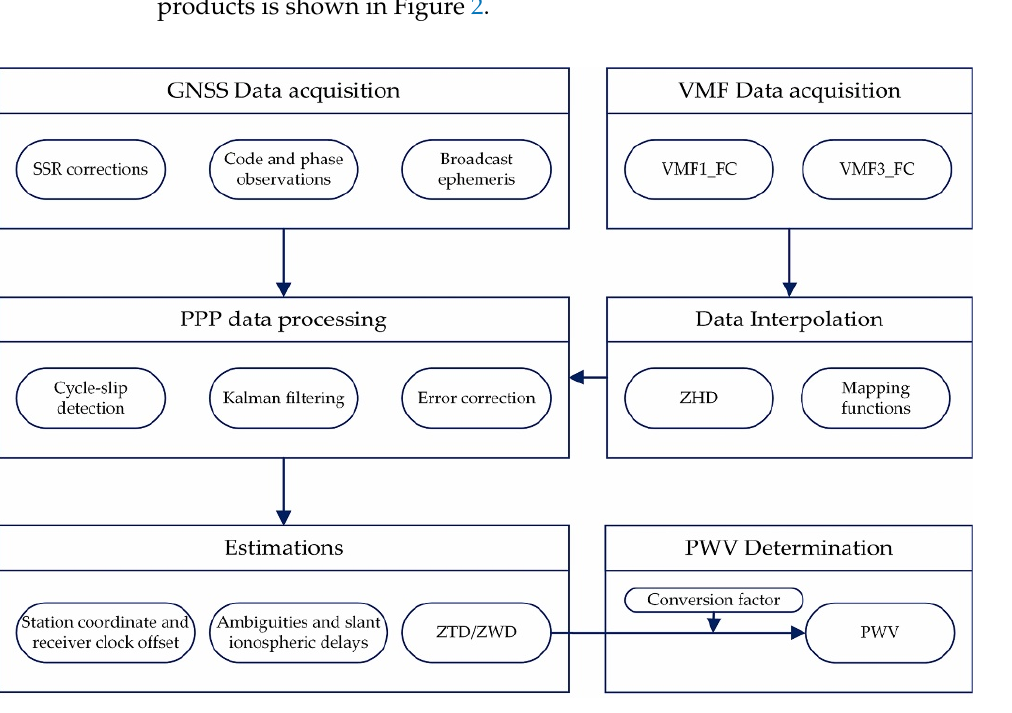
Figure 2. Procedure of the RT-PPP-based PWV retrieval utilizing VMF1/VMF3 forecasting prod- ucts.